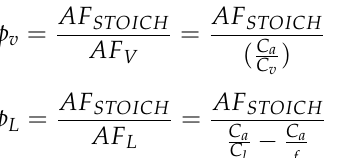
ratios of vapor and liquid phase could be estimated by applying Equations (4) and (5), respectively.